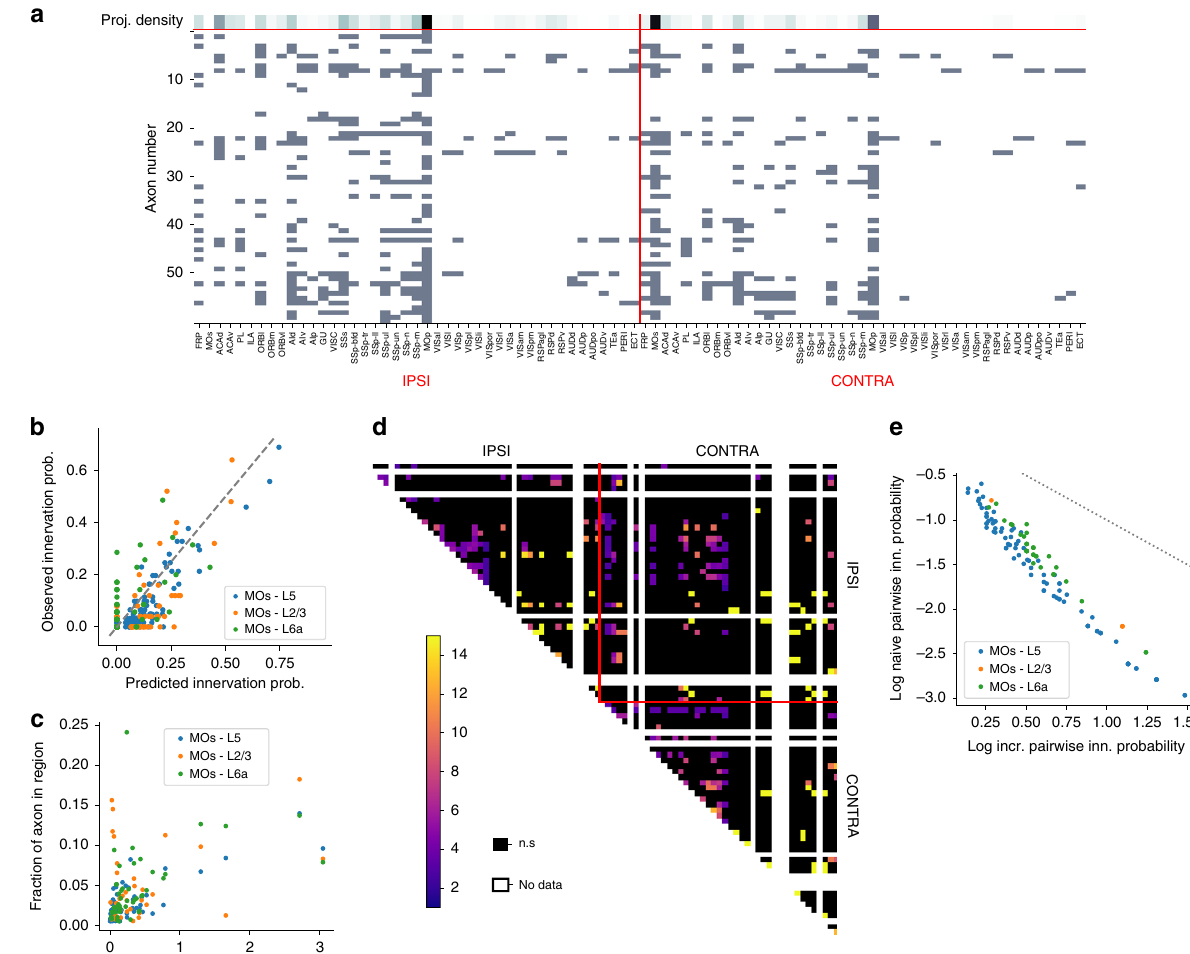
Fig. 5 Innervation of brain regions by individual axons. a Projection density according to Harris et al. 3 (top row), ranging from no projection (white) to strong projections (black), and brain regions innervated by 61 reconstructed axons (rows) indicated by gray squares. b Probability to innervate individual brain regions, predicted from the normalized projection strength from MOs, against the observed innervation probability (L2/3: calculated from n = 25 axons, L5: n = 61 axons, L6a: n = 35 axons). c Normalized projection strength against the mean total length of axon branches in individual brain regions ( n as in b ). d Observed interactions between the innervation of individual brain regions, i.e., increase in innervation probability of one region when the other is known to be innervated. e Increase in innervation probability as in d against the innervation probability of a pair of regions under the assumption of independence. Gray dotted line indicates the point where the product of independent probability and increase is one that can logically not be exceeded. All innervations and projection strengths in this fi gure are for projections from